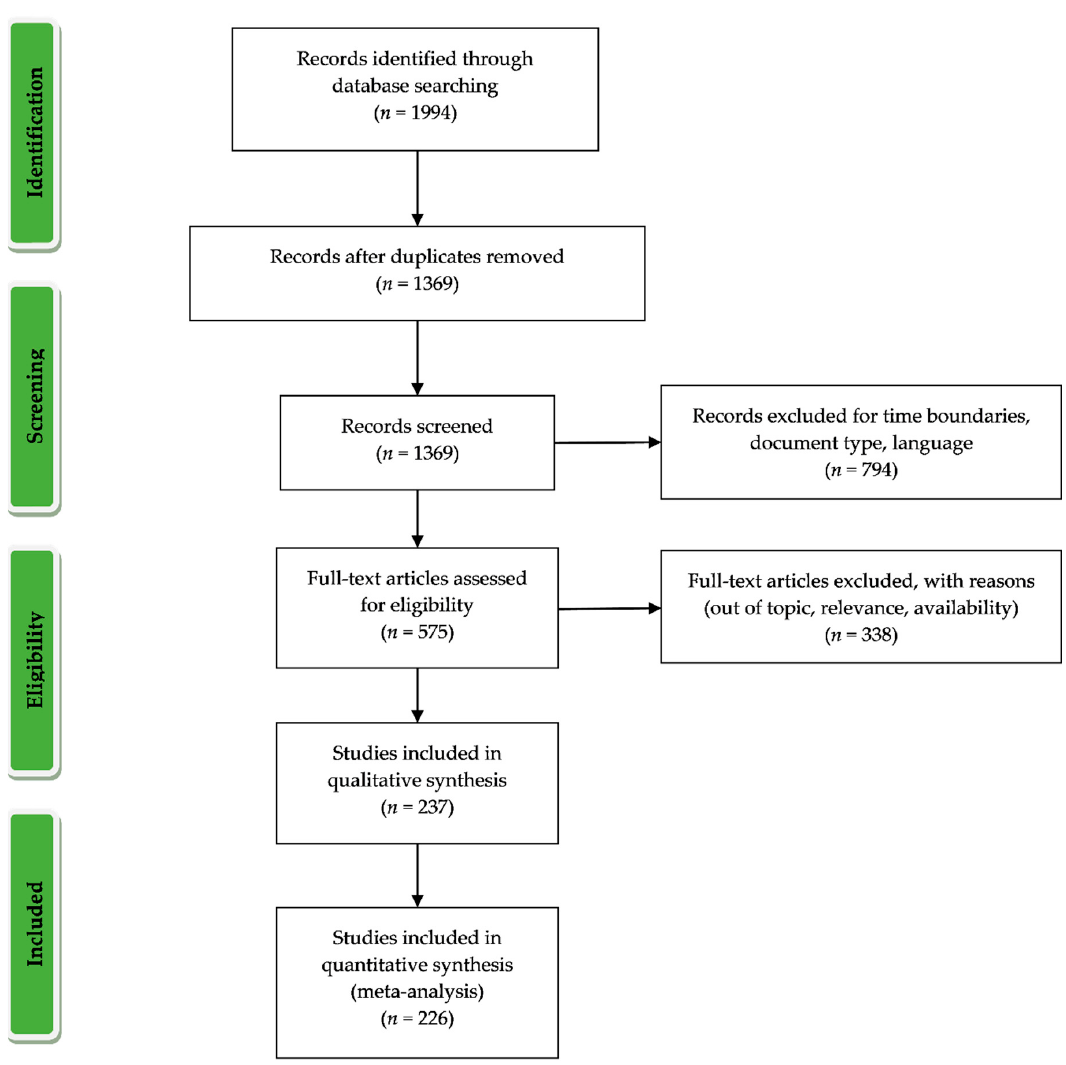
Figure 2. Workflow (PRISMA diagram) showing the phases of the database creation ( n = number).